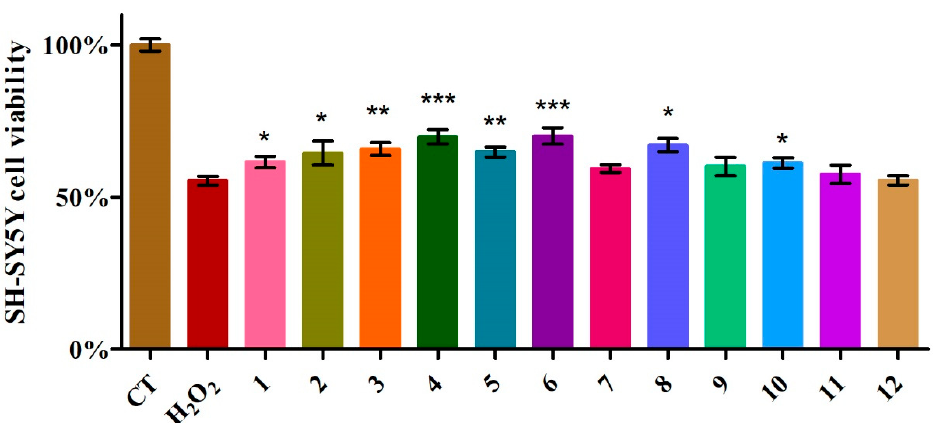
Figure 4. The protective effects of the different compounds (* means the P value compared with H 2 O 2 group is lower than 0.05; ** means the P value compared with H 2 O 2 group is lower than 0.01; *** means the P value compared with H 2 O 2 group is lower than 0.001).